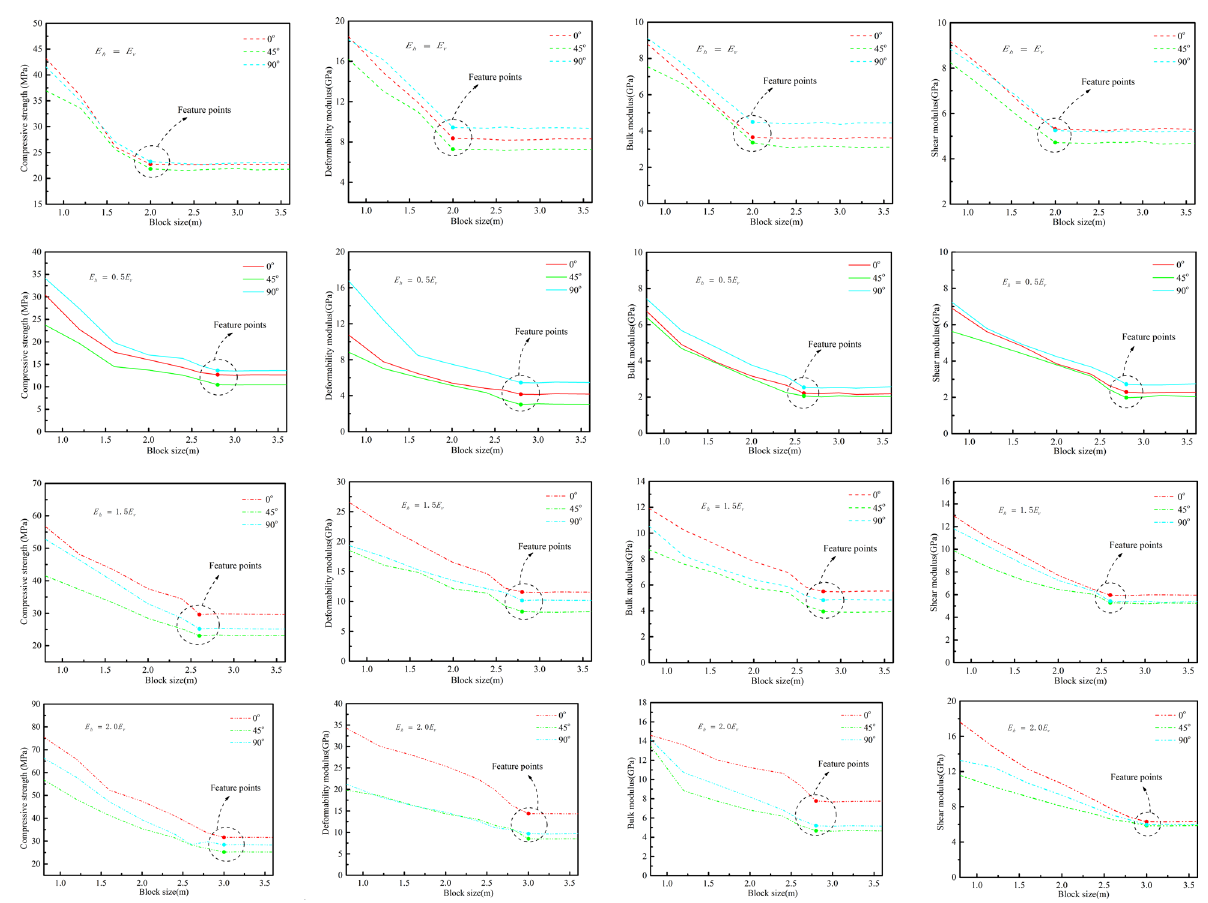
Fig. 11 Variation in the mechanical parameters with respect to the bedding angle and block size under the same anisotropy